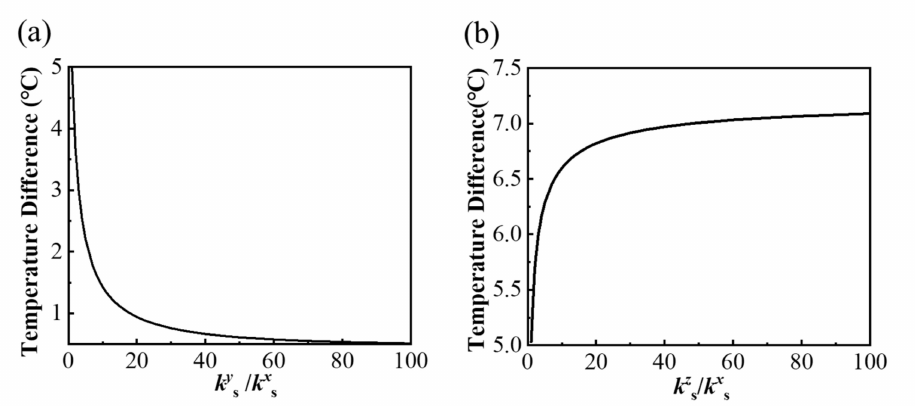
Figure 5. Effects of the orthotropic substrate with different ratios of ( a ) k sy / k sx and ( b ) k sz / k sx on the thermal uniformity of the bottom surface of the